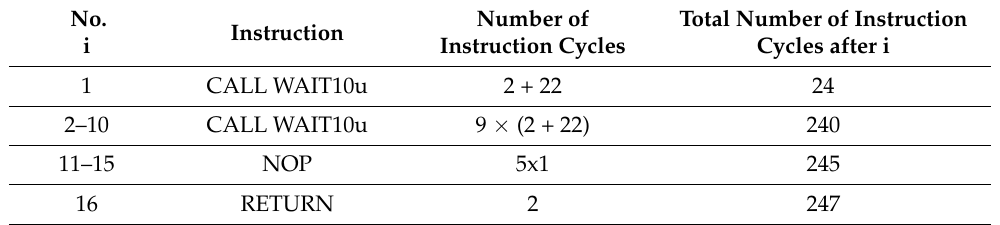
Table 5. Subroutine for 100 µ s time delay.